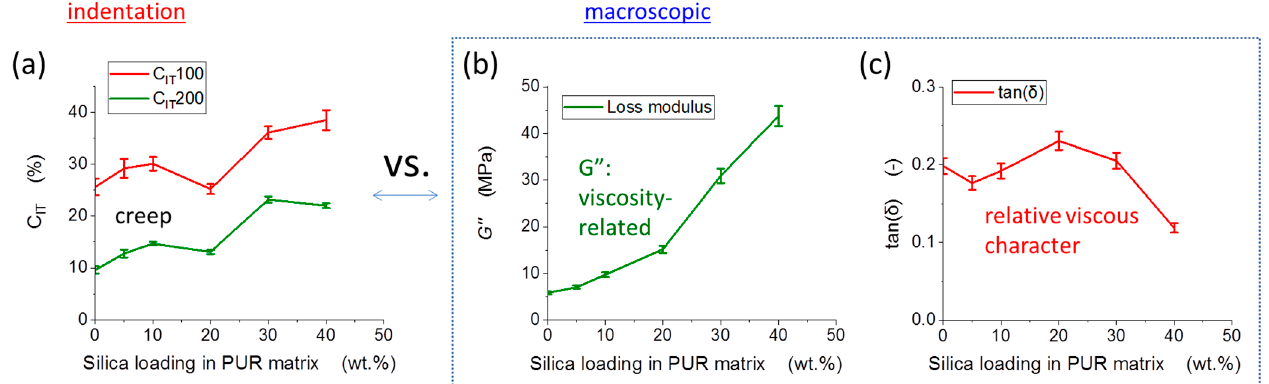
Figure 10. Energy dissipation-related magnitudes in microindentation ( a ), DMTA: loss modulus ( b) , and DMTA: loss factor ( c ): Comparison of trends: effect of nanofiller loading, all measured at T = 25 °C.